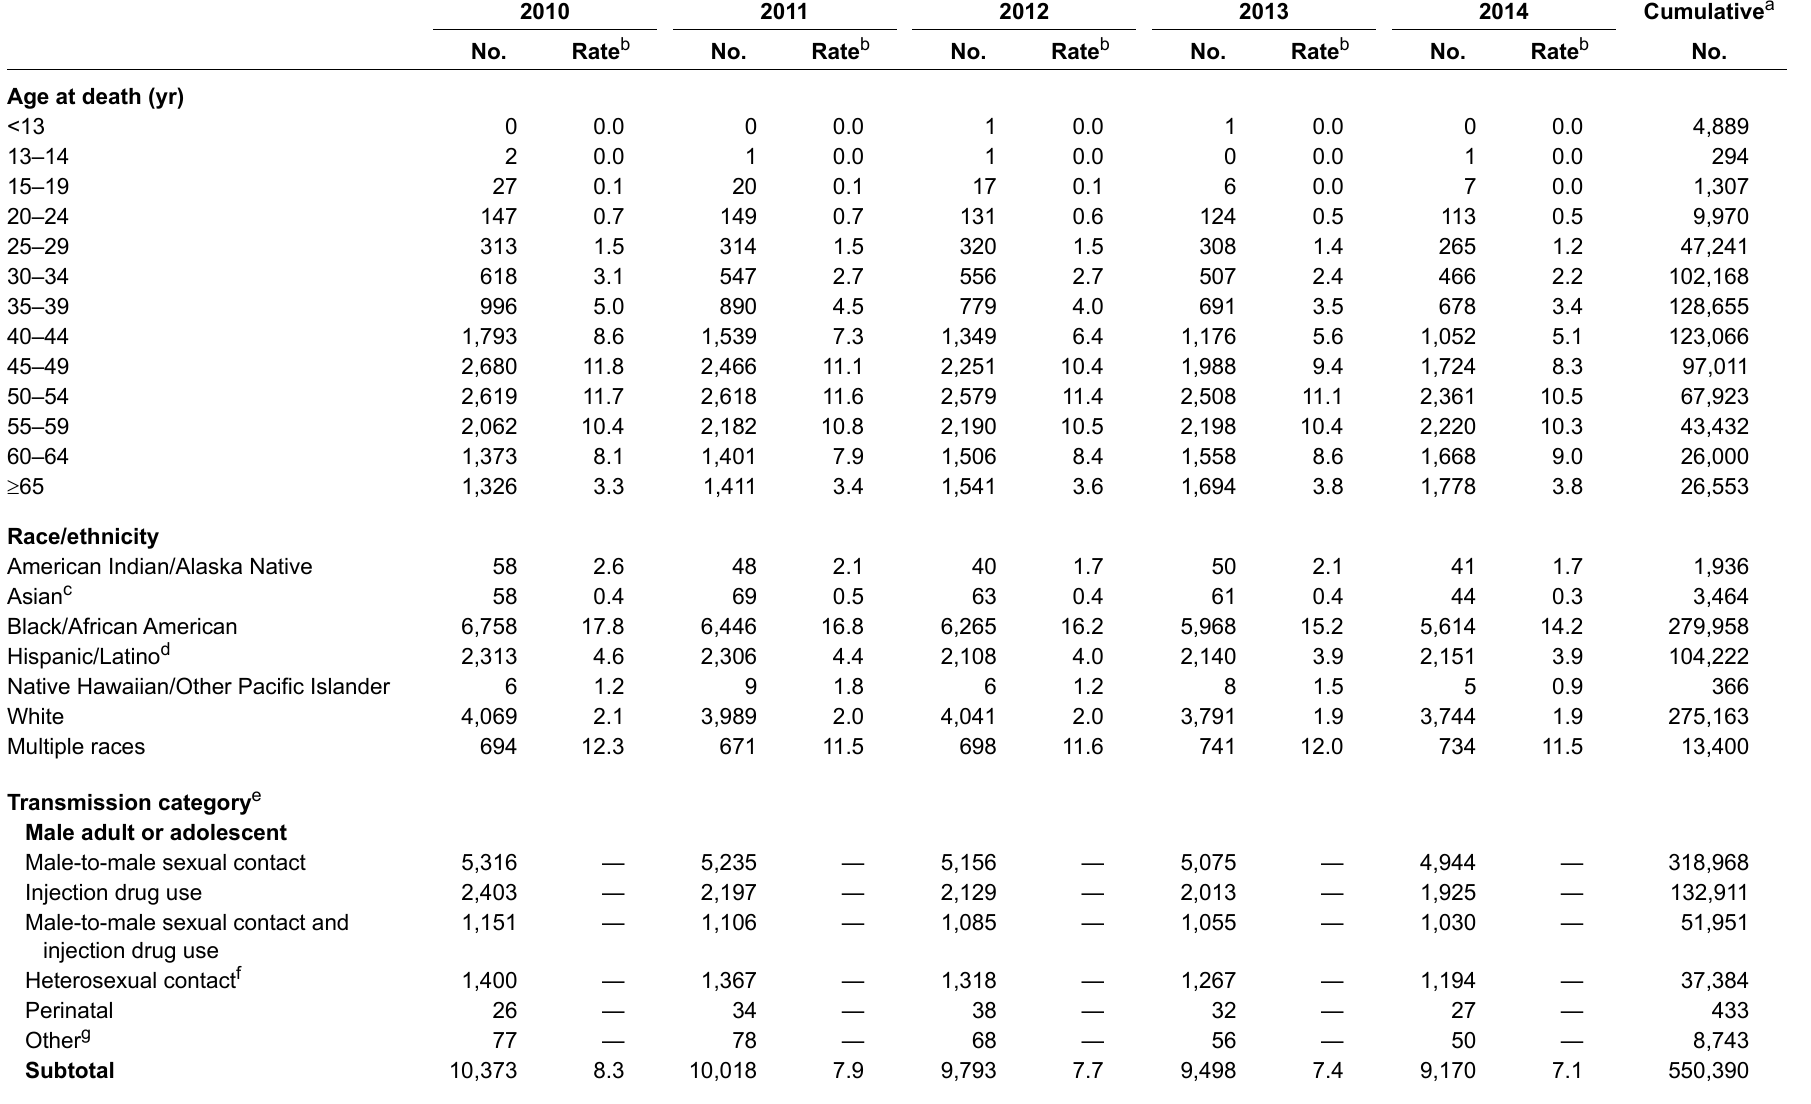
Table 13a. Deaths of persons with diagnosed HIV infection ever classified as stage 3 (AIDS), by year of death and selected characteristics, 2010–2014 and cumulative—United